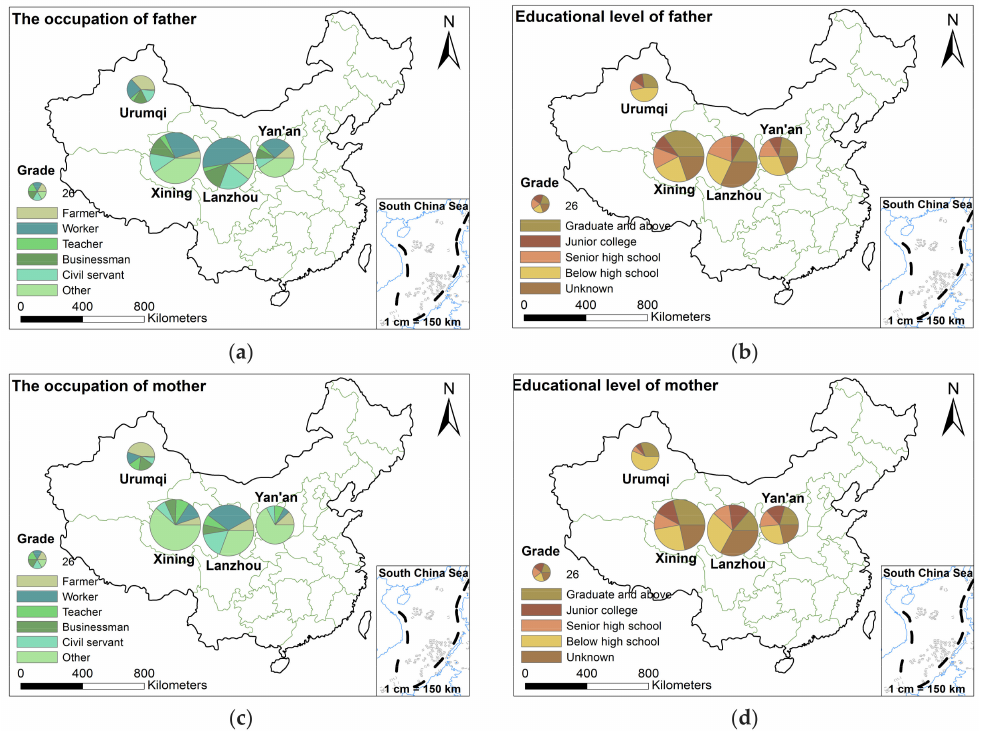
Figure 4. The basic situation of parents ( a ) for father’s occupation; ( b ) for father’s education level; ( c ) for the mother’s occupation; ( d ) for mother’s education level.